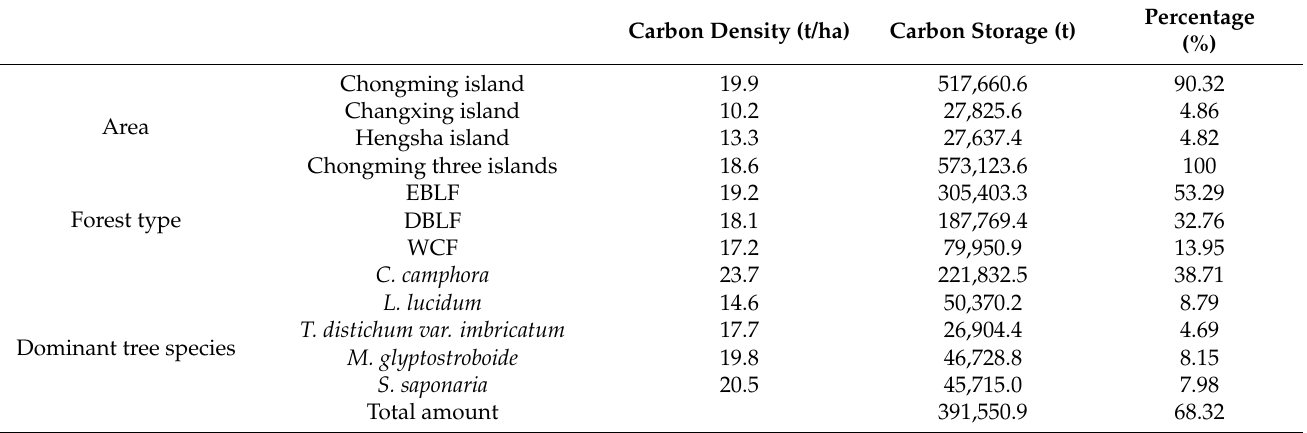
Table 4. Average forest carbon density (t/ha) and carbon storage across Chongming eco-island (three islands) at the scales of different forest types and dominant tree species. EBLF: evergreen broad-leaved forest, DBLF: deciduous broad-leaved forest, and WCF: warm coniferous forest. Percentage Carbon Density (t/ha) Carbon Storage (t)